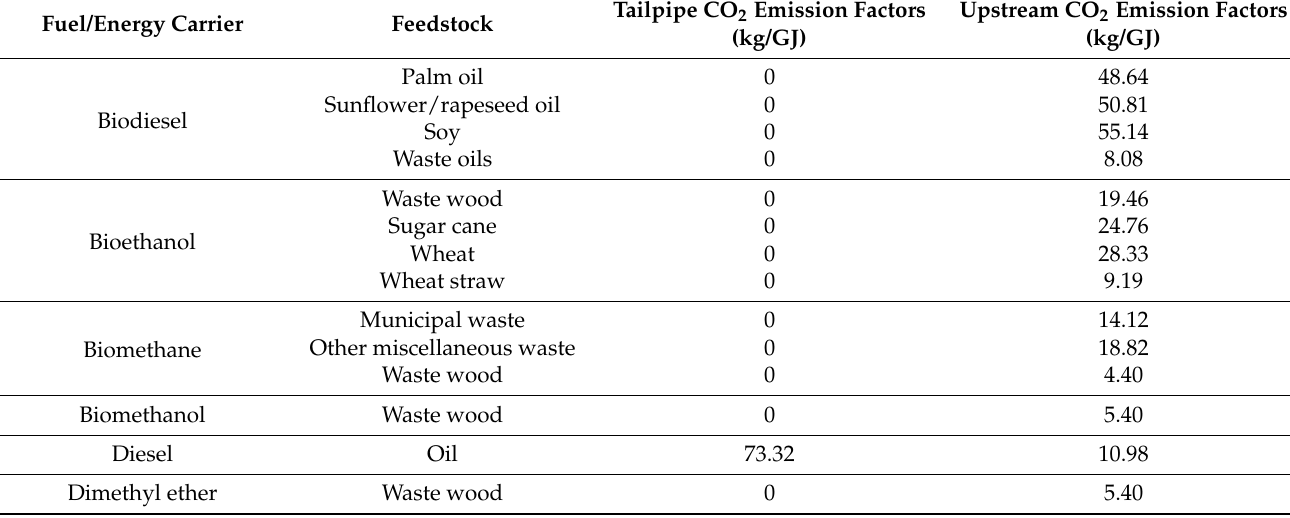
Table A1. Tailpipe and upstream carbon dioxide (CO 2 ) emission factors